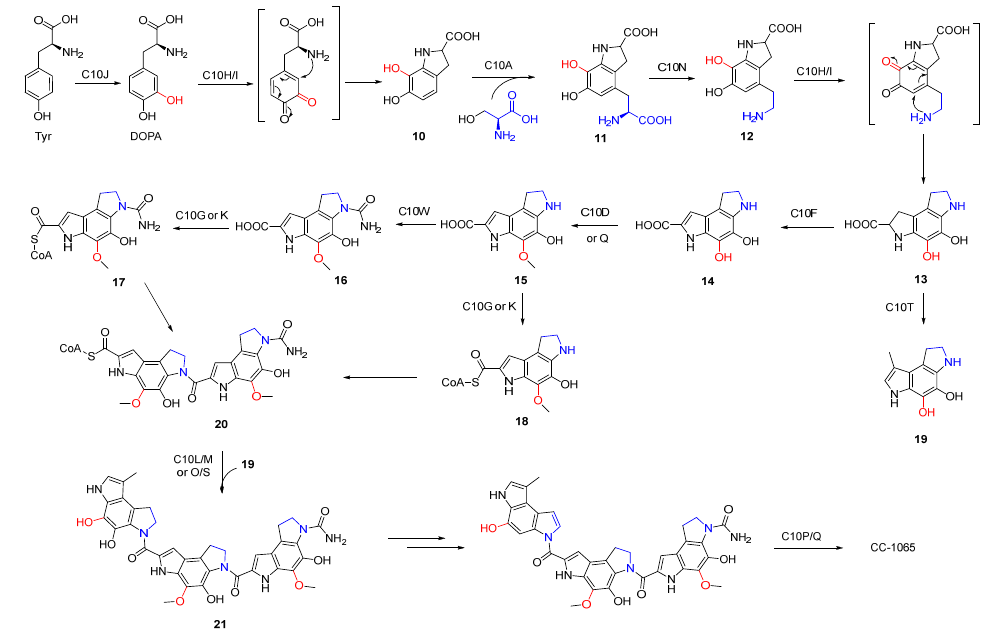
Figure 4. Proposed biosynthetic pathway of CC-1065.